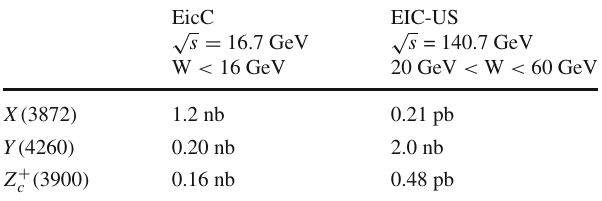
Table 2 Total cross sections of XY Z exotic states in two W regions in electron–proton scattering for proposed EICs, with 0.01 GeV 2 < Q 2 < 1.0 GeV 2 . The collider energies are listed at second row and the W regions are in third row. The predictions of EicC are performed in low energy models, while the predictions of EIC-US are employed in high energy models EicC EIC-US √ s = 16.7